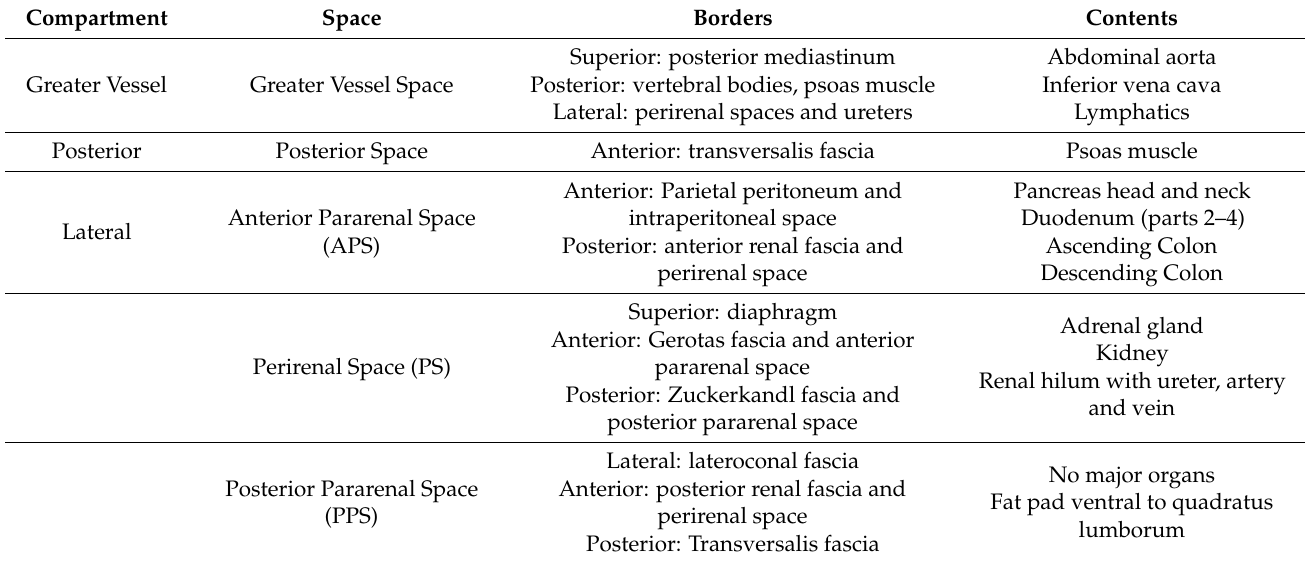
Table 1. Retroperitoneal compartments with associated spaces, borders and